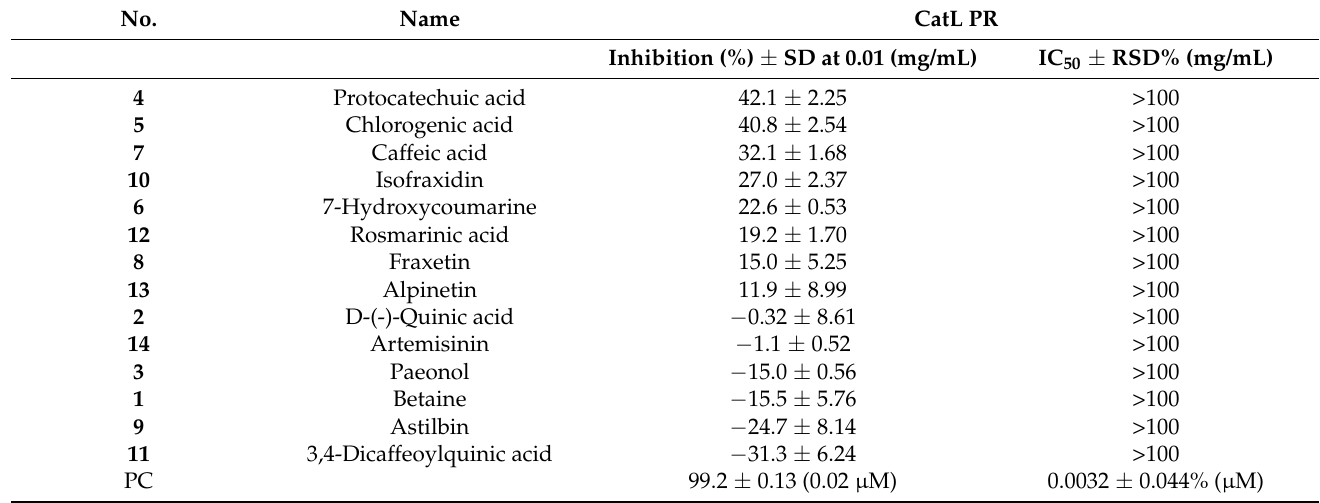
Table 3. Inhibition of CatL PR by major ingredients of SG extracts ( n = 3).